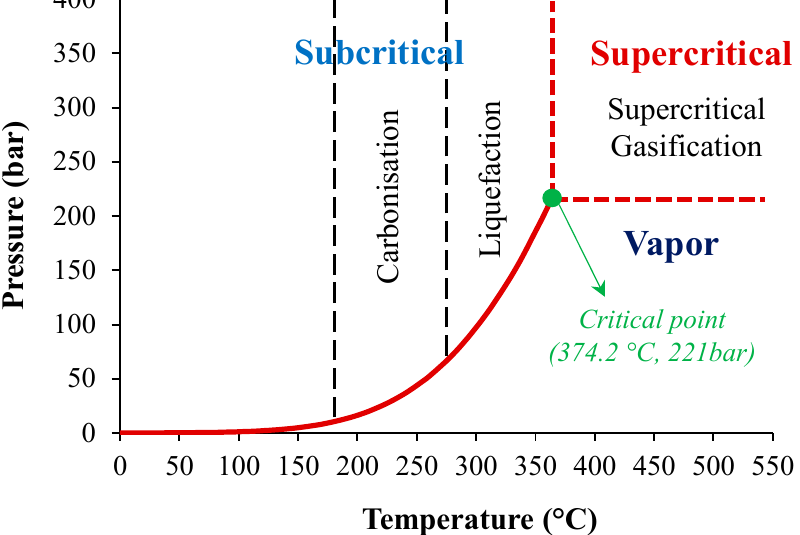
Figure 7. Hydrothermal processing condition in water phase diagram. Adapted from [67].